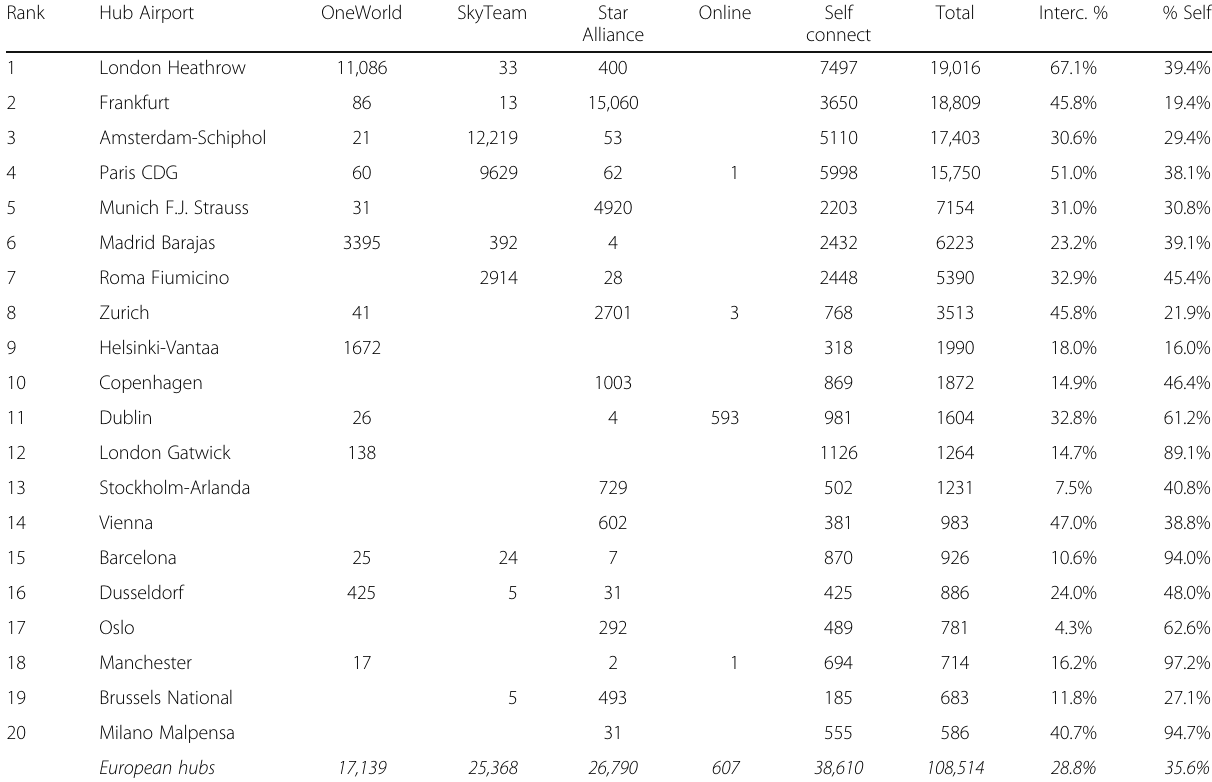
Table 11 First 20 European hubs in terms of number of extra-European viable connections by type